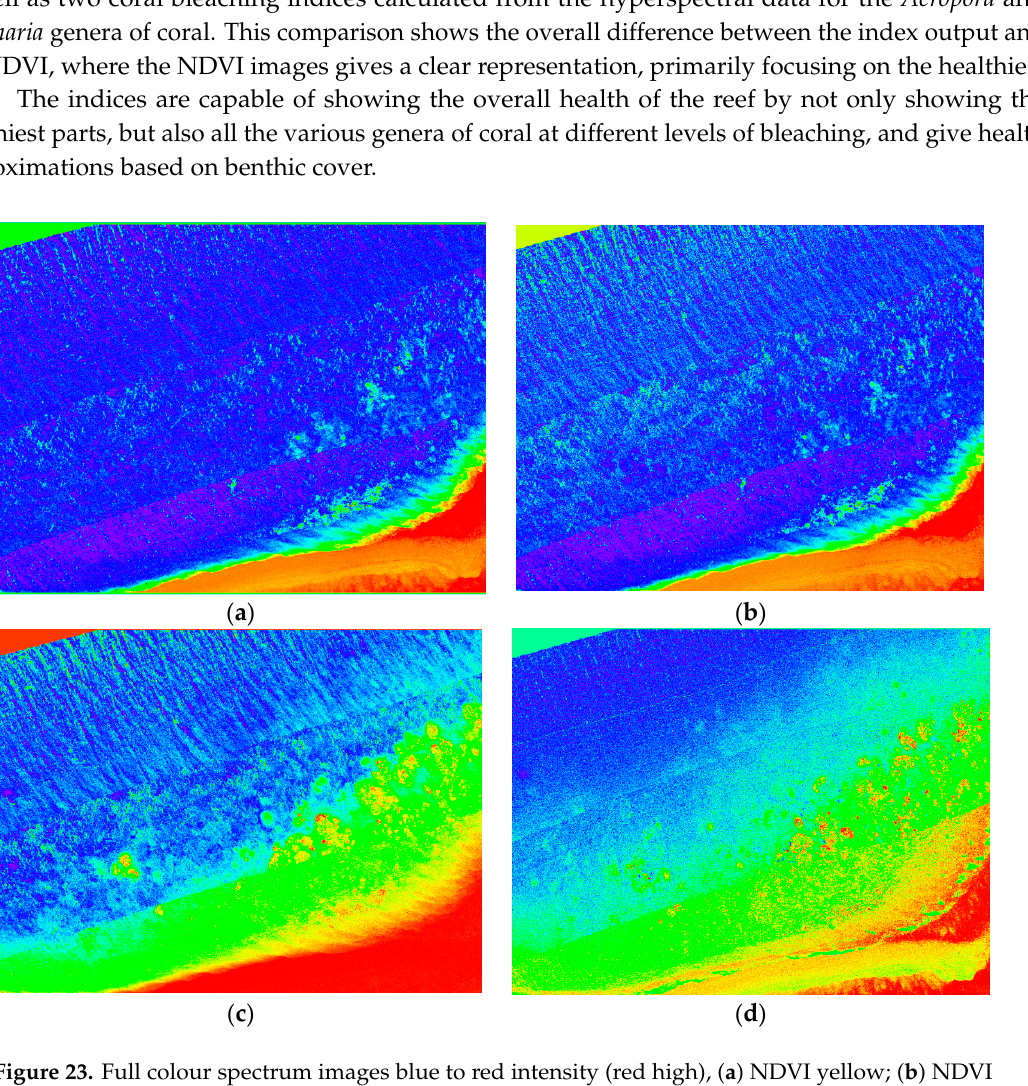
Figure 23. Full colour spectrum images blue to red intensity (red high), ( a ) NDVI yellow; ( b ) NDVI green; ( c ) Turbinaria index Tlv5.3; ( d ) Acropora index